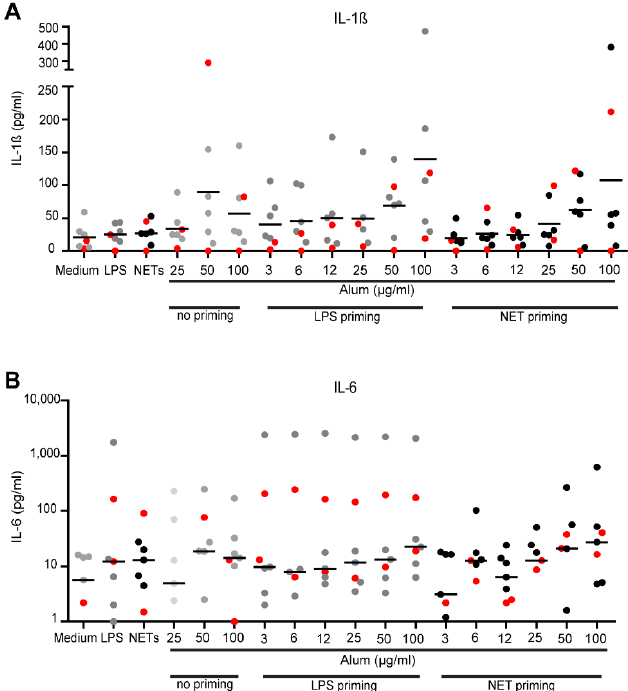
Figure 6. IL-1 β and IL-6 production in PBMC induced by lipopolysaccharide (LPS)- or NET- priming and alum stimulation. PBMC were incubated for 3 h with either medium (neg. control), ultrapure LPS (25 pg/mL) or isolated NETs (100 ng/mL) and then stimulated for 6 h with increasing doses of alum (3, 6, 12, 25, 50 and 100 μ g/mL). Cytokine levels of ( A ) IL-1 β and ( B ) IL-6 in SN were measured by ELISA. Cumulative data of 3 independent experiments with 7 different donors are shown. Red dots indicate allergic donors. One-way ANOVA followed by Dunnetts post tests.